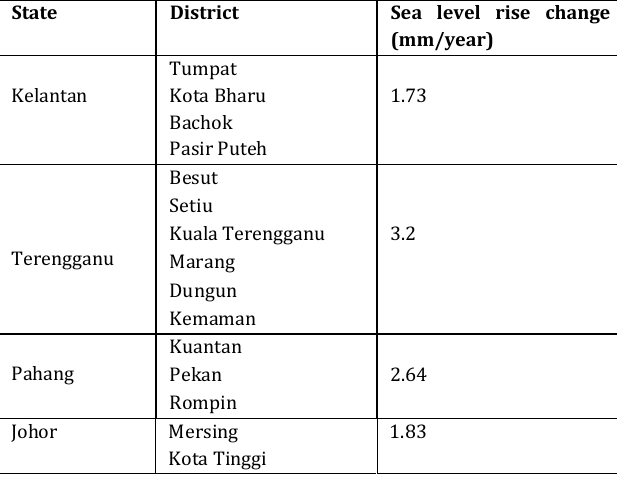
Table 6: Sea level rise change along the East Coast of Peninsular Malaysia.